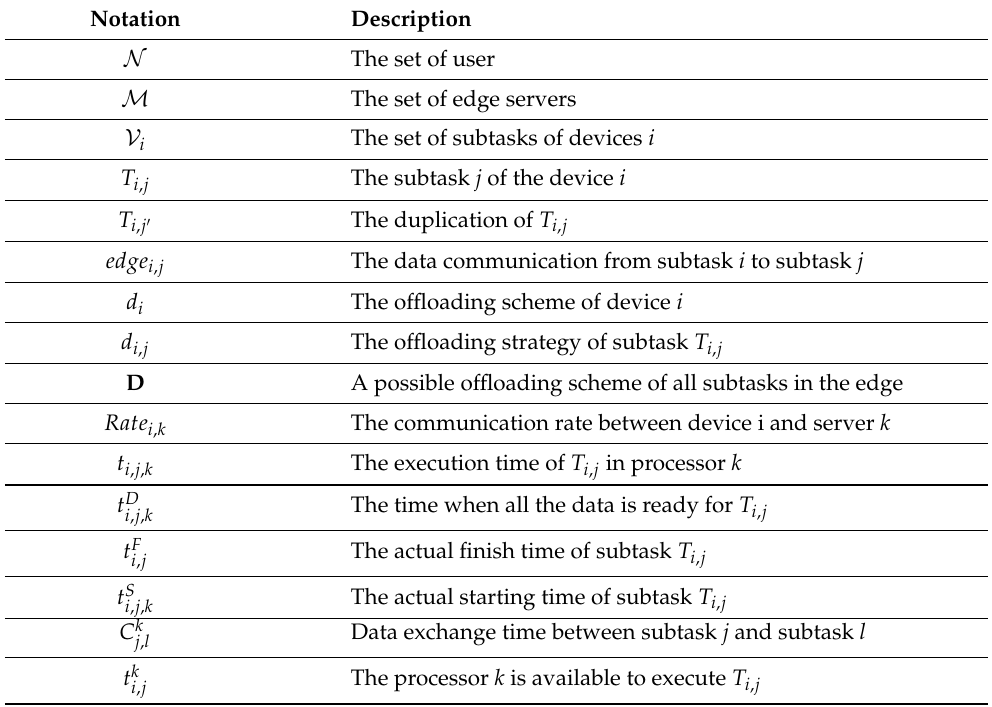
Table 2. Notations used in the